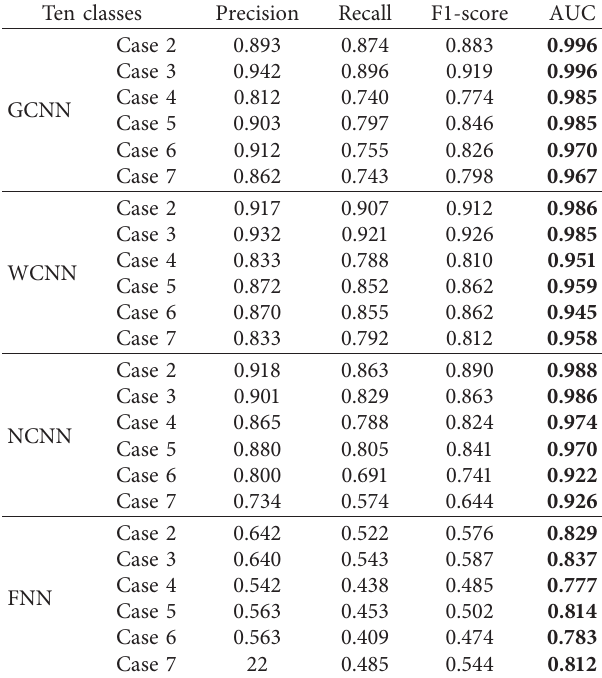
Table 5: Performance of different deep learning methods in ten- classes